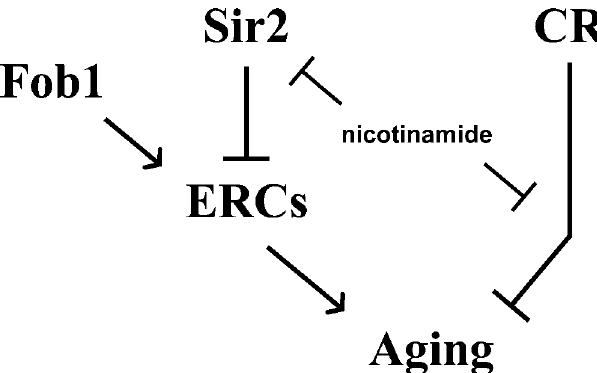
Figure 5. Genetic Pathways Determining Replicative Life Span in Yeast Sir2 and CR act in parallel pathways to slow aging. Both pathways are affected by nicotinamide levels. DOI: 10.1371/journal.pgen.0010069.g005